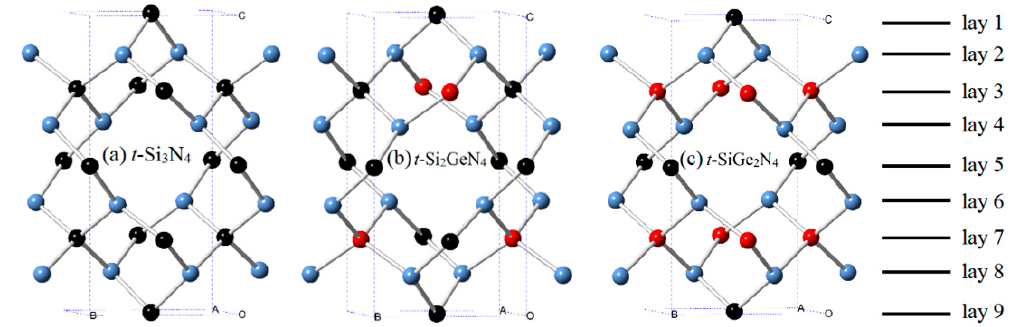
Figure 1. Crystal structures of t -Si 3 N 4 ( a ); t -Si 2 GeN 4 ( b ); and t -SiGe 2 N 4 ( c ) at ambient pressure. The silicon, germanium, and nitrogen atoms are represented as black, red, and blue spheres, respectively.